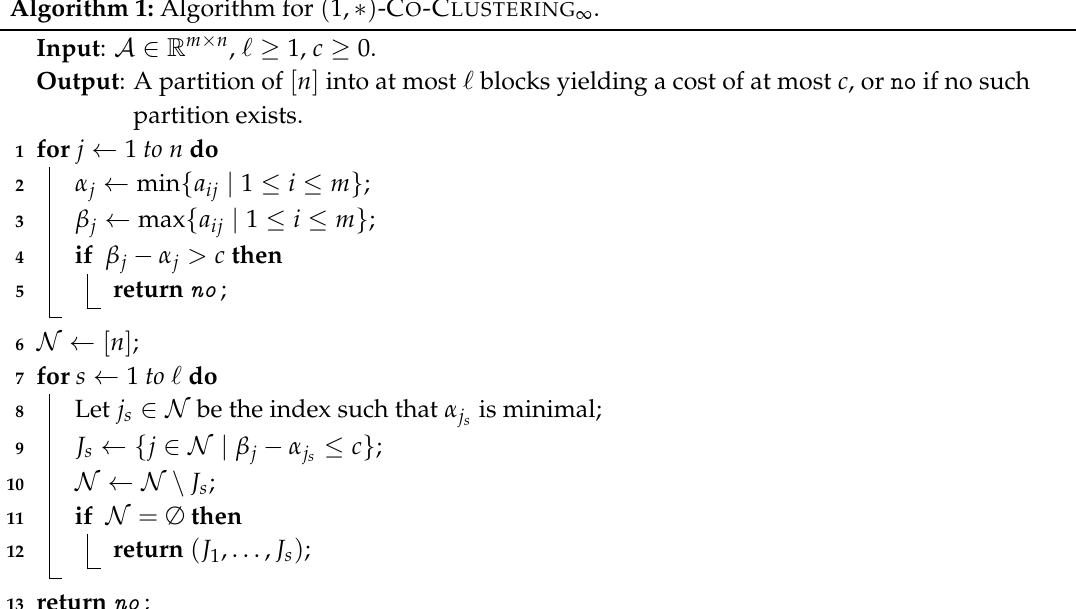
Algorithm 1: Algorithm for ( 1, ∗ ) -C O -C LUSTERING ∞